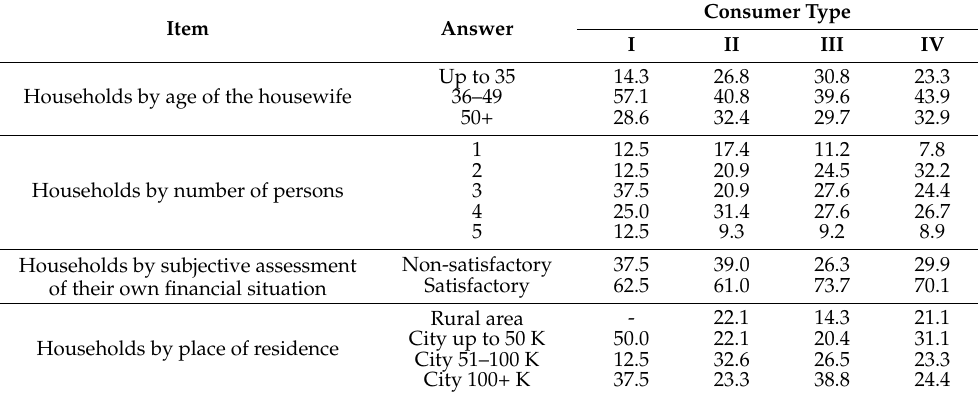
Table 10. Characteristics of Slovak consumer households ( n = 300, in %).